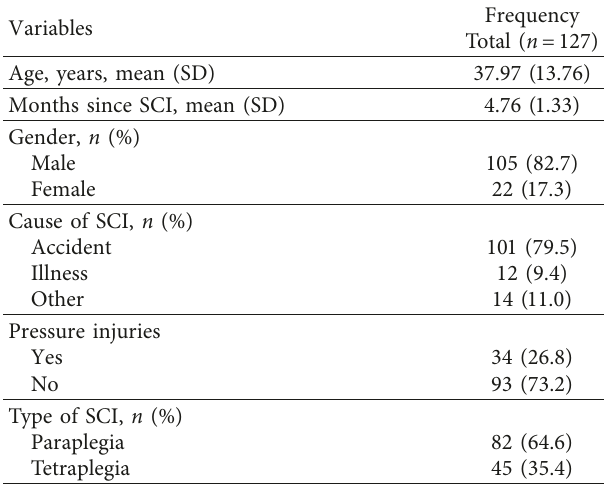
Table 2: Sociodemographic characteristics of individuals with